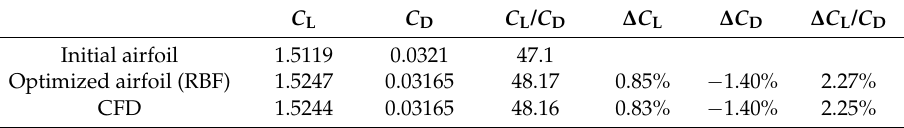
Figure 26. Pressure coefficient distribution of the initial and optimized airfoils. Table 4. Aerodynamic performances of the initial and optimized airfoils.